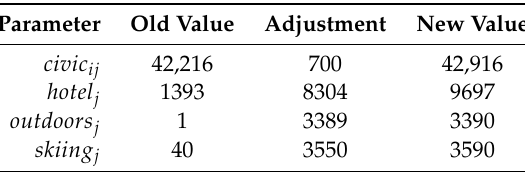
Table 5. Inputs for scenario